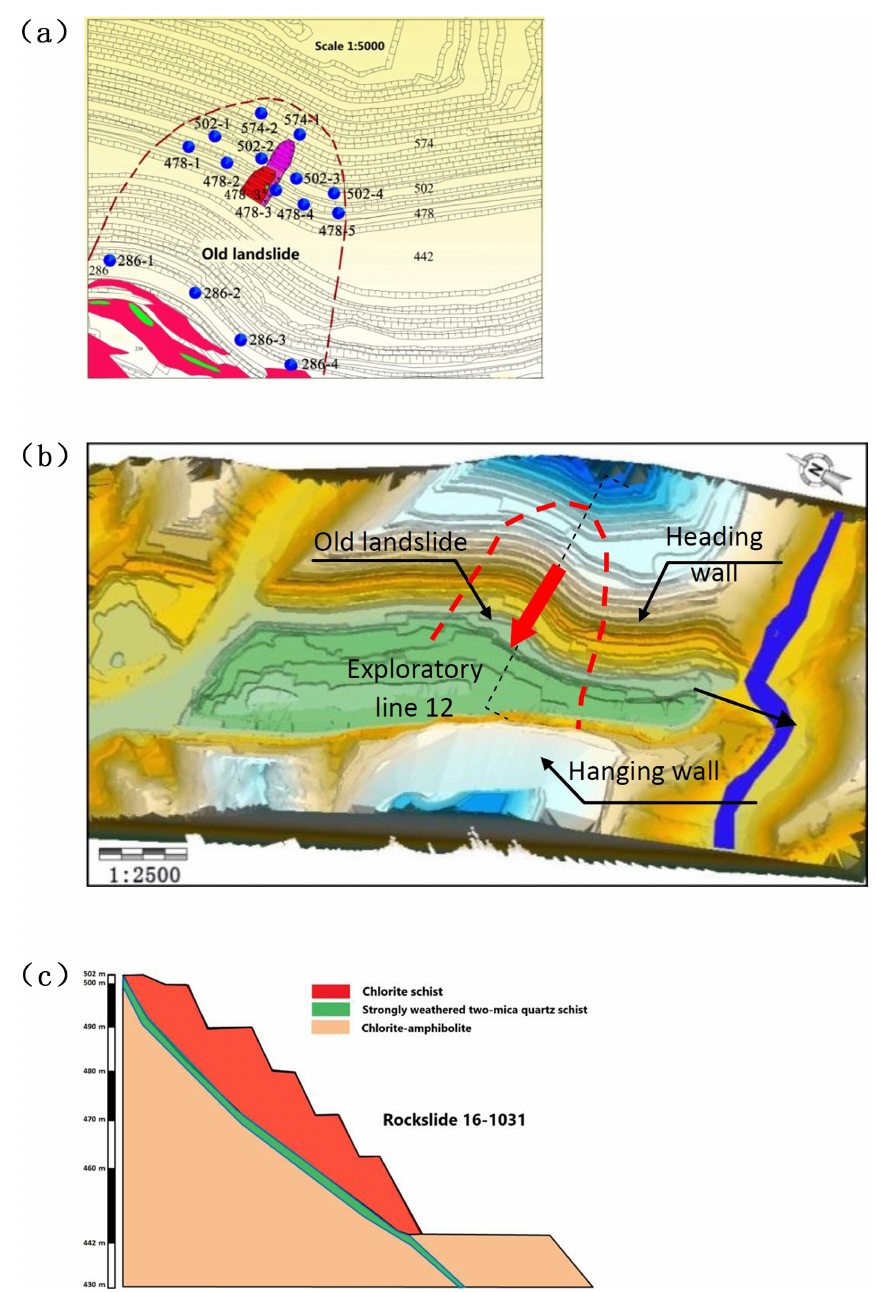
Figure 2. (a) Plan graph of the Nanfen open-pit iron mine rockslide location. The red area shows the location of the studied landslide that occurred on 31 October 2016. The purple zone shows the boundary of a rockslide that occurred in 2011. Blue circles show the current distribution of force monitoring points, and the green one, 478-3’, indicates the CRLD cable that was employed during the rockslide in 2011. (b) Relief map of the Nanfen mine. (c) Geological profile along exploratory line